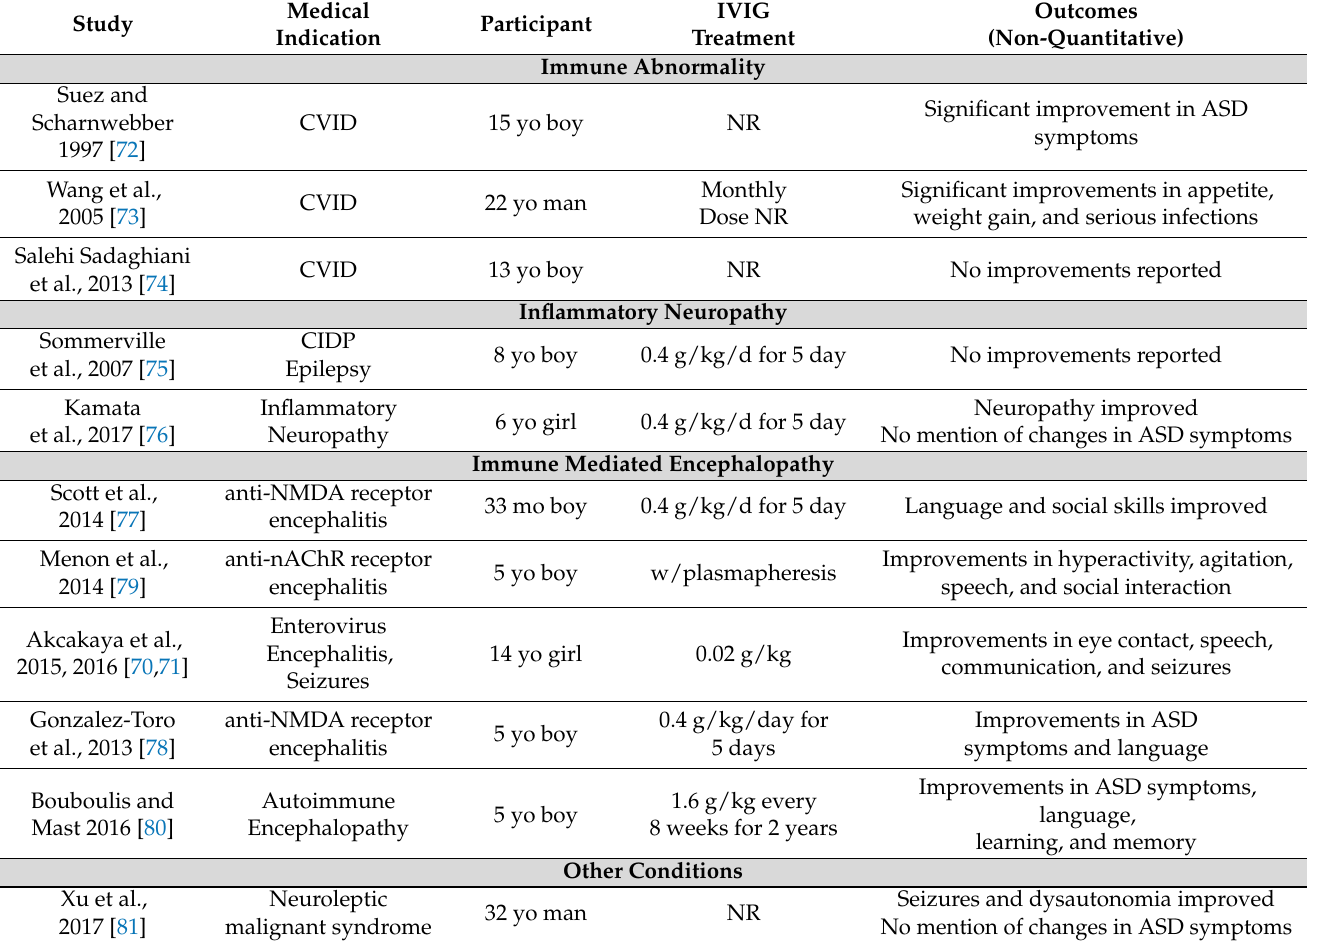
Table 7. Retrospective Uncontrolled Case Studies of Immunoglobulin G Treatment in Autism Spectrum Disorder. Chronic inflammatory Demyelinating Polyneuropathy (CIDP); Common Variable Immunodeficiency (CVID); N-Methyl-D-Aspartic Acid (NMDA); Nicotinic Acetylcholine Receptor (nAChR); Not Reported (NR), month old (mo), years old